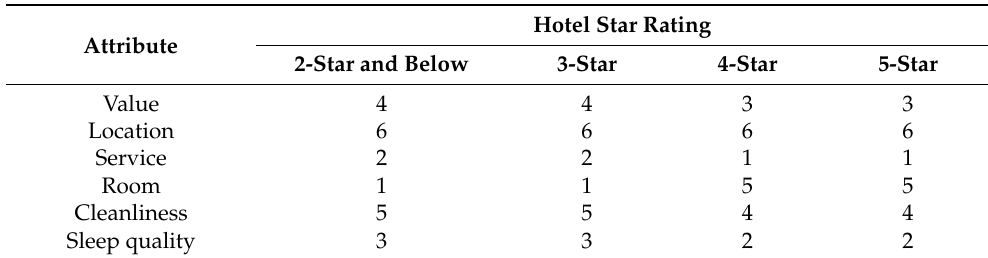
Table 12. The attribute priority rankings of the six attributes for resource allocation concerning four hotel star ratings.